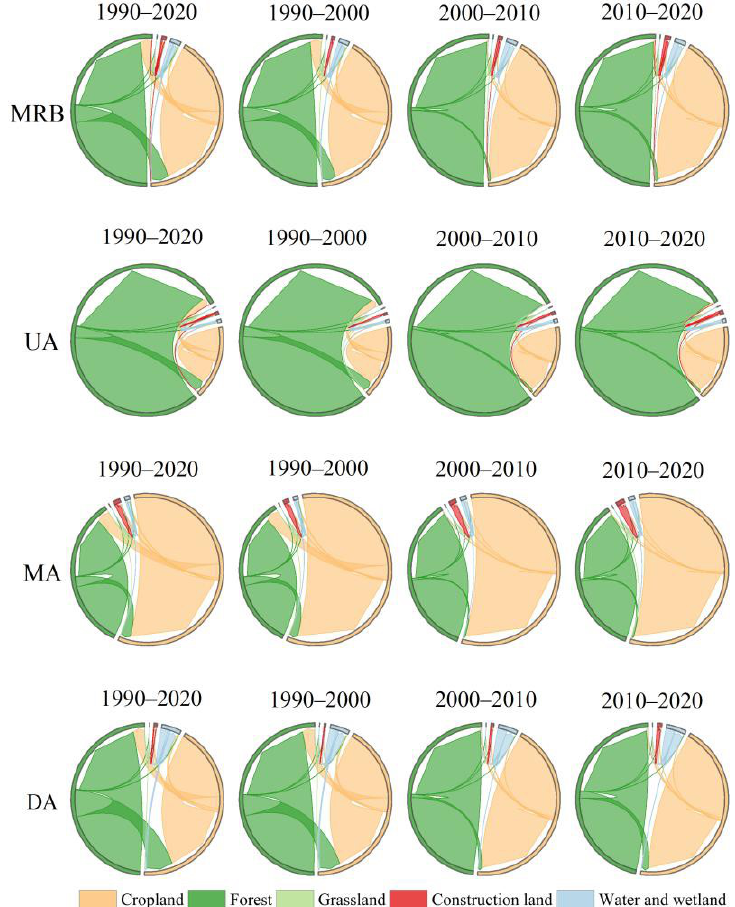
Figure 3. Land-use transfer in the Mekong River Basin (MRB) and its upstream area (UA), midstream area (MA), and downstream area (DA) during 1990–2020, 1990–2000, 2000–2010, and 2010–2020. Note that the arrows indicate the direction of transfer, and the width indicates the amount of